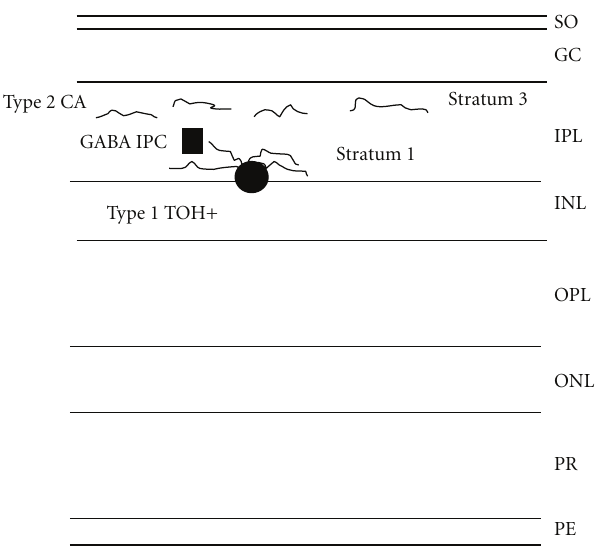
Figure 1: The layers of the retina (PE: pigment epithelium, PR: visual receptors, ONL: outer nuclear layer, OPL: outer plexiform layer, INL: internal nuclear layer, IPL: internal plexiform layer, GC: ganglion cell layer, and SO: Stratum opticum). Dopamine neurons (TOH+: Tyrosine hydroxylase positive neurons, Type 1 cells and Type 2 amacrine cells) are primarily concentrated in the INL and dopamine positive neurites (Type 1 in stratum 1 and type 2 ramify above stratum 1) in the IPL. Type 1 cells may synapse onto GABA interpelexiform cells (IPCs). Some dopamine activities may also be observed in the ganglion cell layer.